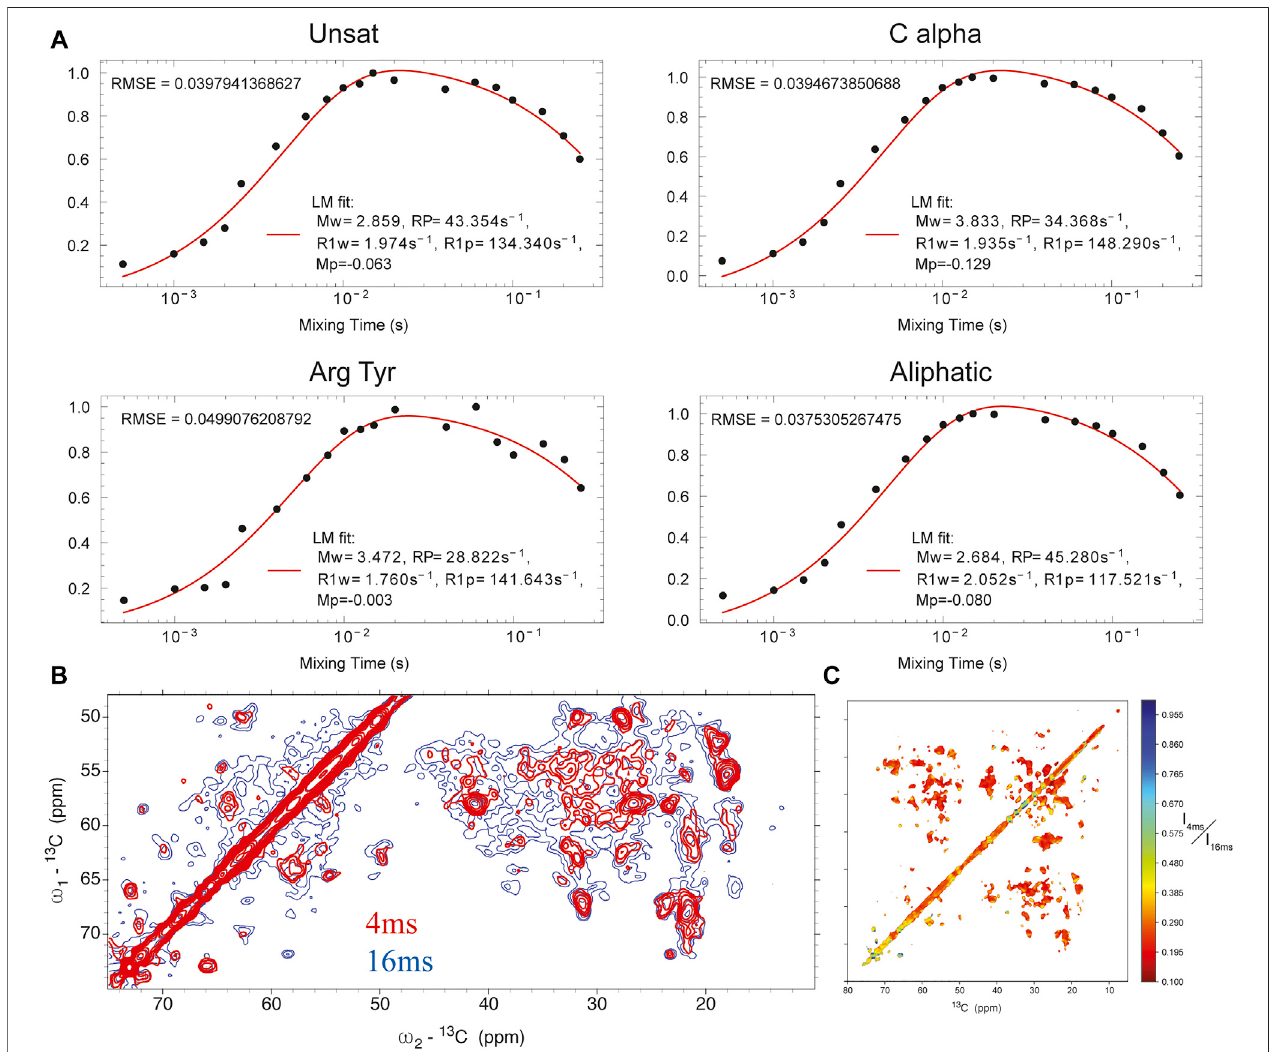
FIGURE 1 | (A) buildup curves for different regions of the protein as a function of 1 H water - 1 H protein mixing time. (B) 13 C- 13 C DARR spectrum with 4 ms 1 H water - 1 H protein mixing (red) overlaid onto a similar spectrum with 16 ms of spectrum compared to 16 ms